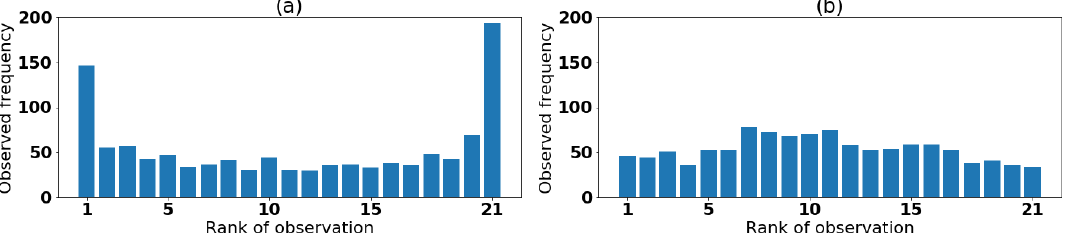
Figure 13. Comparison of the rank histogram of (a) the single MLP (SMLP) and (b) multiple MLP (MMLP) for the ephemeral snow class using the testing data